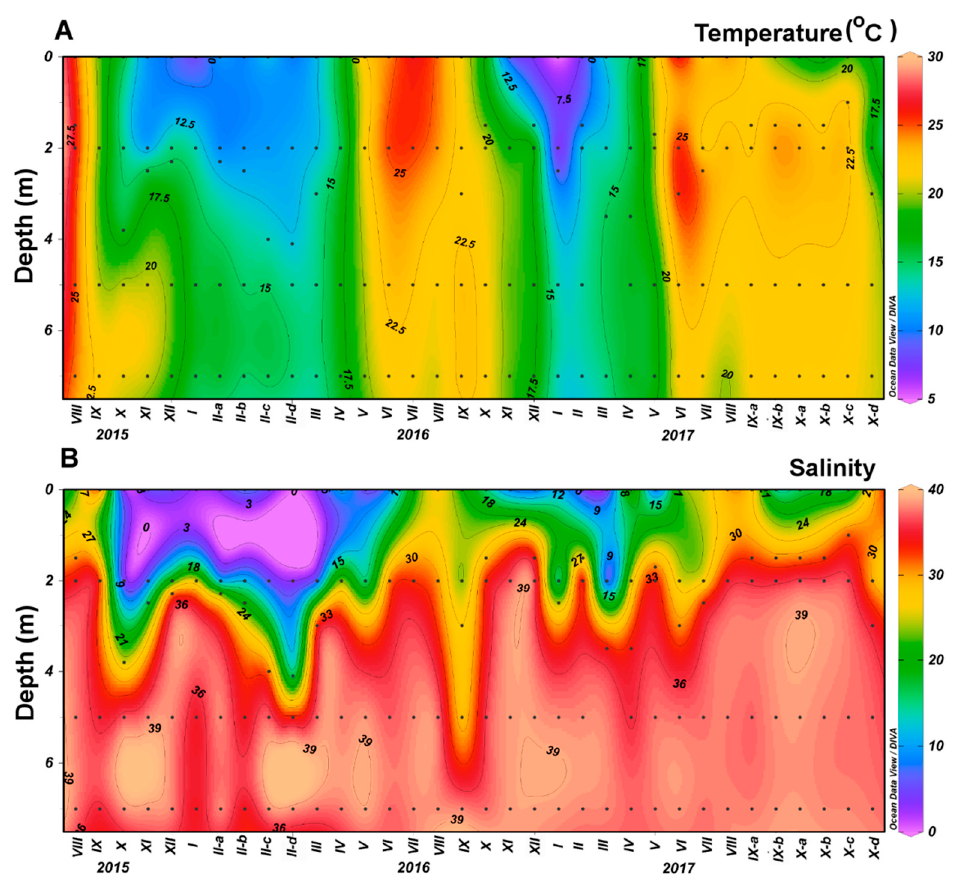
Figure 8. Vertical profile of temperature ( A ) and salinity ( B ) throughout the investigated period at Strmica station.